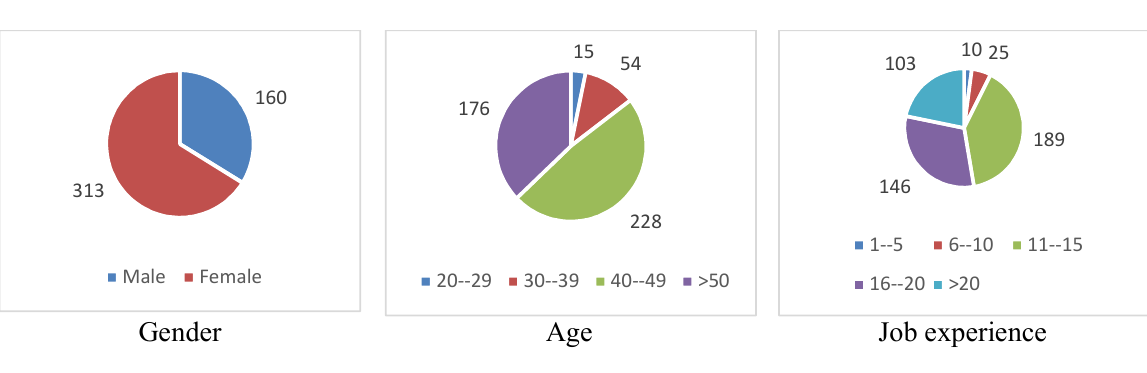
Fig. 2. Personal characteristics of the